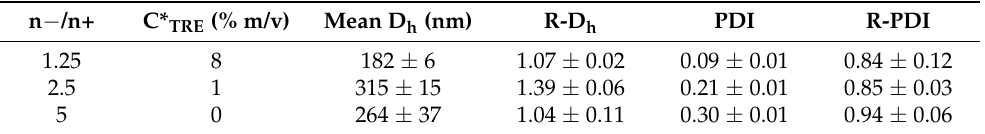
Table 1. Characteristics of HA/DEAE-D PEC-NGs (C P = 0.5 g.L − 1 ) reconstituted after freeze-drying at the lowest trehalose concentrations allowing homogeneous reconstitution ( n ≥